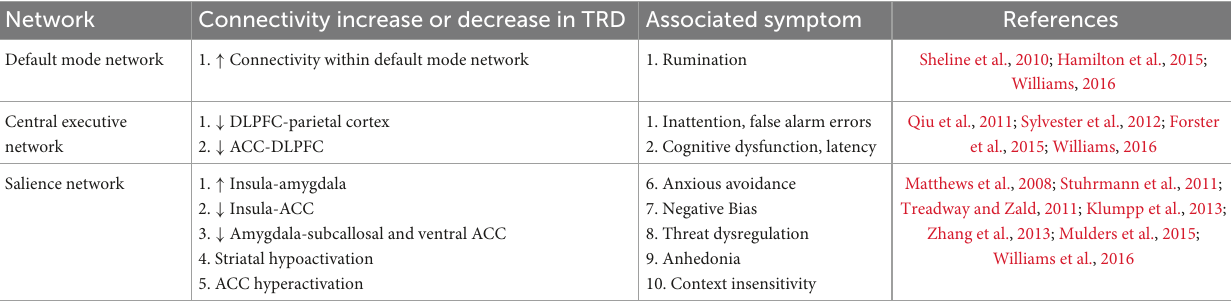
TABLE 2 Network connectivity changes in treatment-resistant depression (TRD) and resultant symptoms.